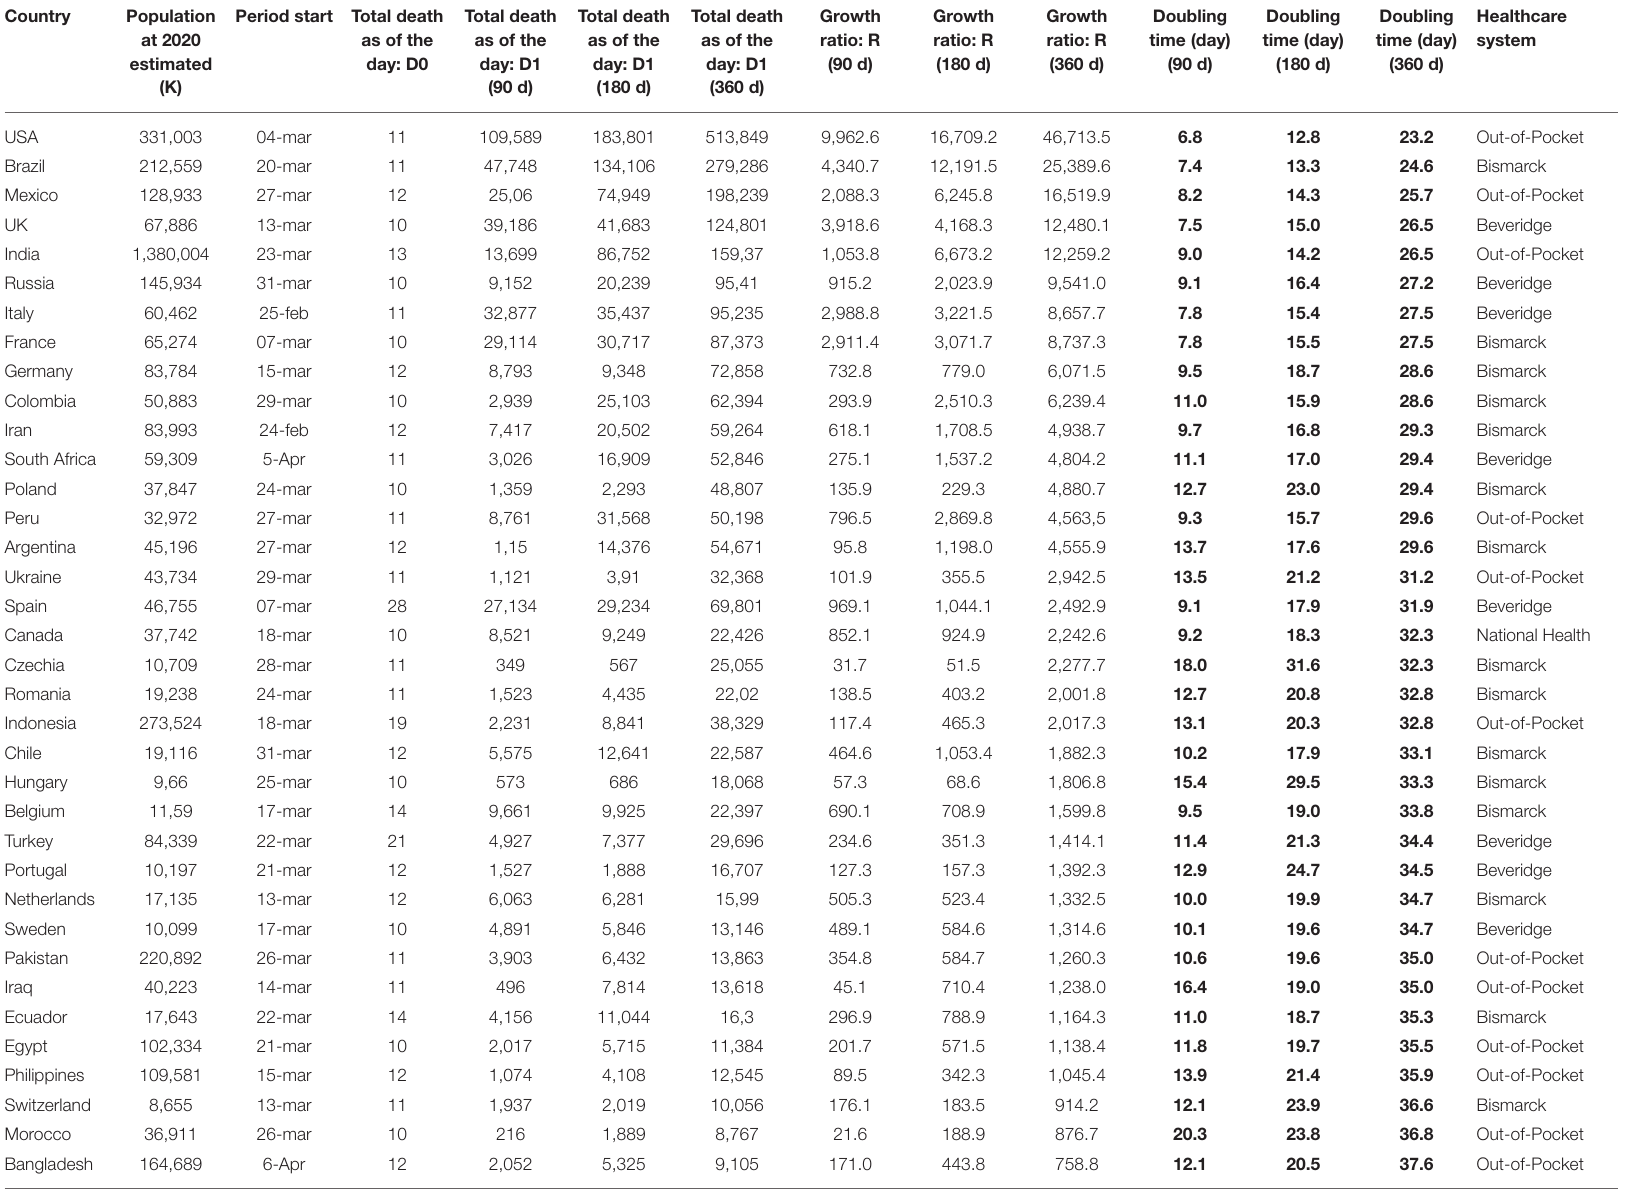
TABLE 1 | DT of the number of deaths by